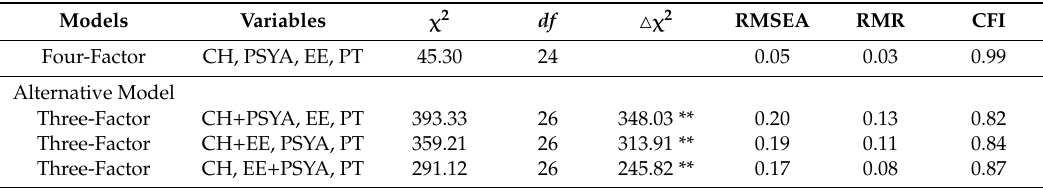
Table 1. Results of confirmatory factor analysis.